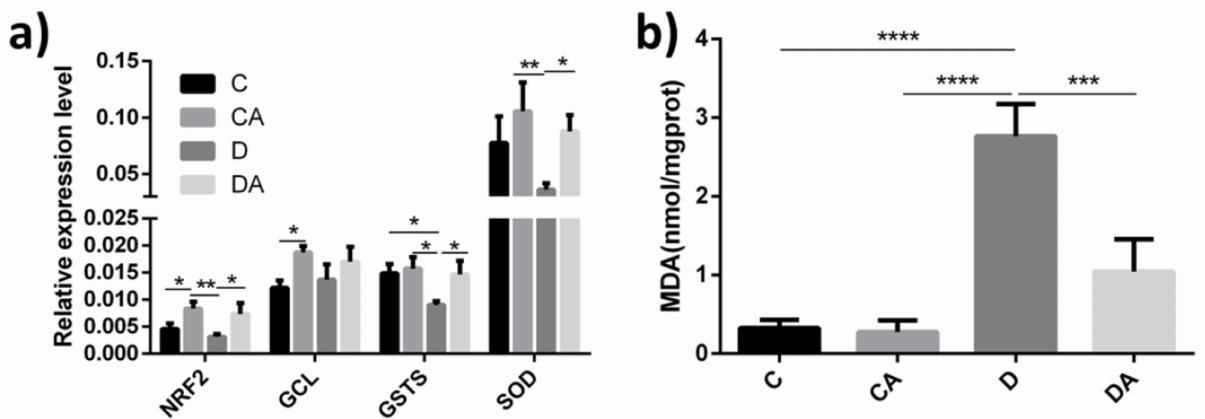
Figure 7. Effects of BANCs on the NRF2 signaling pathway and MDA content in DSS-treated normal female D. melanogaster . C, CA, D, and DA represent the blank control group, BANC control group, inflamed group, and BANC inflamed group, respectively. ( a ) Effects of BANCs on the expression levels of NRF2 signaling pathway genes. ( b ) Effects of BANCs on the MDA content. The mRNA expression levels of genes in the D. melanogaster guts were measured by RT–qPCR. The relative gene expression levels were normalized to Rp49. Data from triplicate repetitions are expressed as the means ± SEMs. Statistical significance: * p < 0.05, ** p < 0.01, *** p < 0.001, **** p <